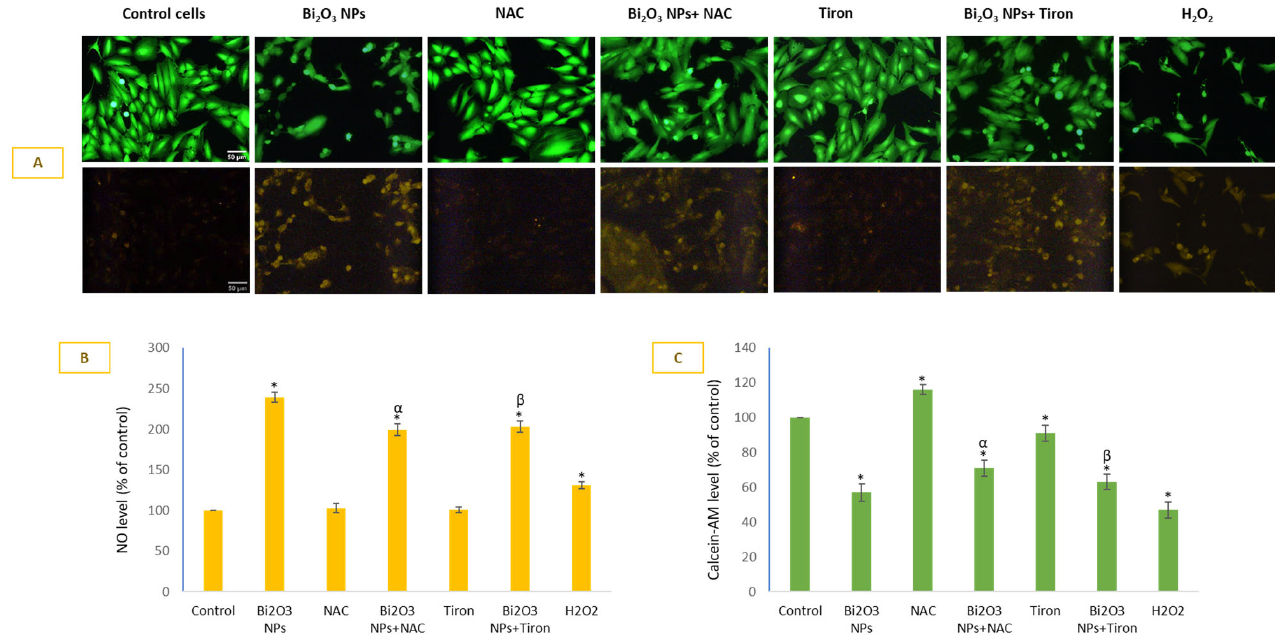
Figure 4. Generation of NO due to BNPs in HUVE cells was determined using NO-specific fluorescent probe DAR-2 (infra-red images in ( A ) and fluorescence plotting in ( B ) for individual cells minus non-cellular background). Note that NO generation was a cytotoxic event in HUVE cells due to BNPs exposure as NO fl uorescence was in an inverse relationship with live cell dye fl uorescence of calcein-AM (green images in A and fl uorescence plo tt ing in ( C ) for individual cells minus non-cel- lular background). Data represented are mean ± SD of three identical experiments ( n = 3) conducted in triplicate. * Statistically signi fi cant di ff erence as compared to the controls ( p < 0.05). Any signi fi - cant ( p < 0.05) di ff erence in response from that mediated by NPs and the addition of either NAC or Tiron is denoted by α and β , respectively. 3.5. BNPs Caused Signi fi cant Loss in MMP and Depletion in Intracellular GSH BNPs induced a loss of MMP in HUVE cells (Figure 5A, JC-1 cell images and Figure 5B, JC-1 green fl uorescence plo tt ing). IC50 of BNPs caused a 143% loss of MMP as com- pared to control cells. However, MMP loss due to NP exposure was signi fi cantly protected by the two antioxidants used in this study. A 1.43-fold increase in JC-1 green fl uorescence caused by NP (in comparison to the control) was reduced to 1.25-fold (or 87% in compar- ison to the control) by NAC and 1.28-fold (or 90% in comparison to the control) by Tiron. Alternatively, MMP loss due to NP treatments was restored by 13% by NAC and 10% by Tiron. Interestingly, exogenously applied H 2 O 2 caused more MMP loss (167% vs. the con- trol) than due to BNP treatment (143% vs. control). BNPs treatment caused 2.4-fold ex- haustion of GSH (Figure 5C) in comparison to the control. Exogenous H 2 O 2 caused a 1.3- fold GSH depletion versus the control. NAC signi fi cantly restored GSH, and this could be another explanation for the NAC-mediated prevention of cells against BNPs-induced tox- icity.